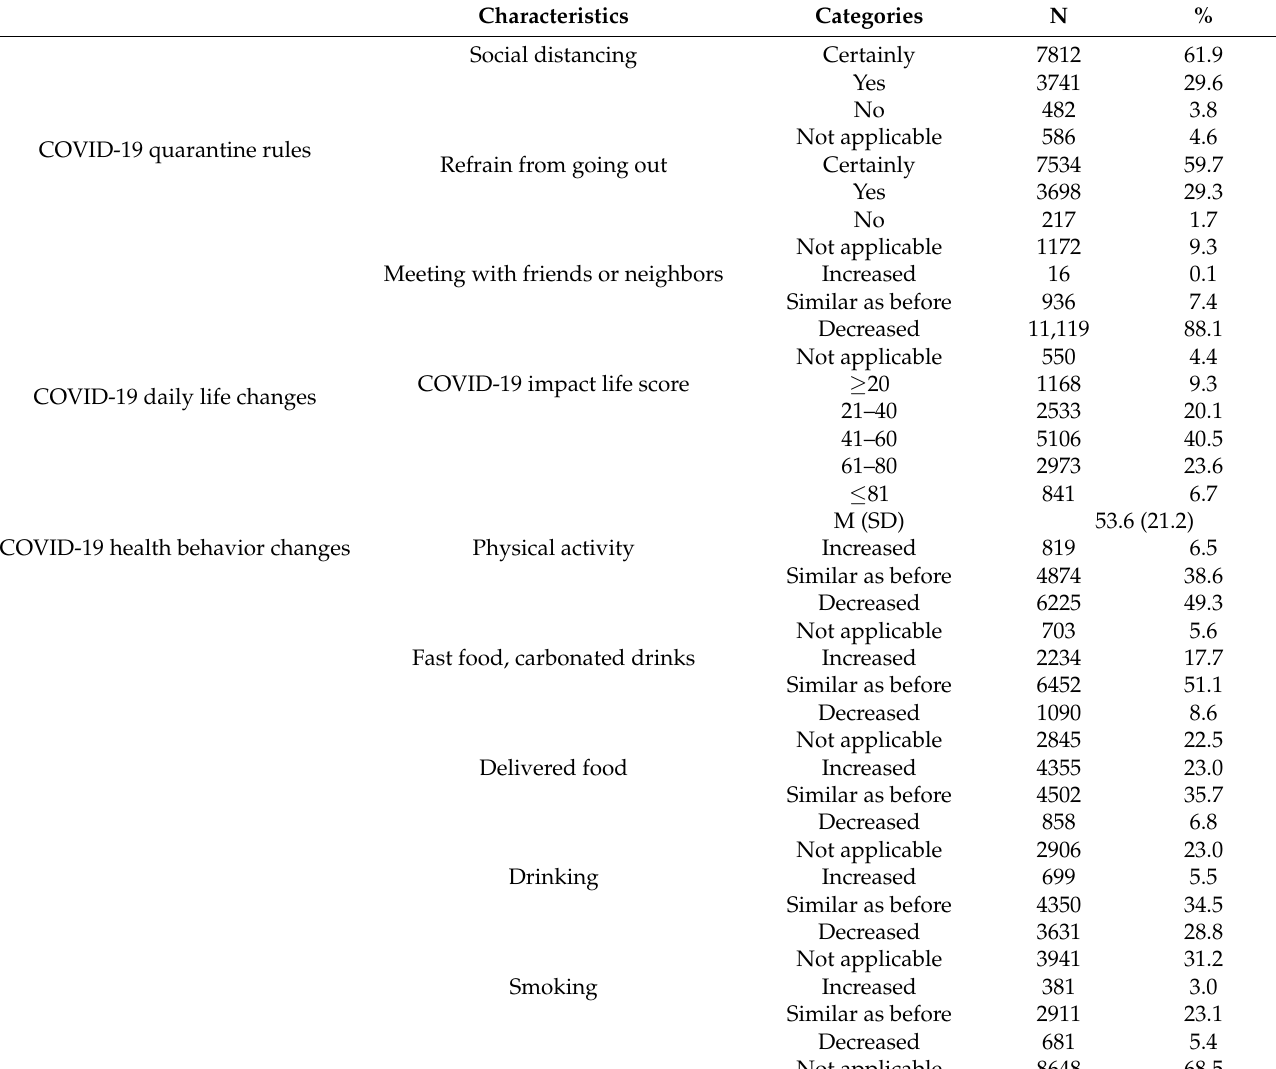
Table 2. Participants’ implementation of COVID-19 quarantine rules, changes in daily life, and changes in health